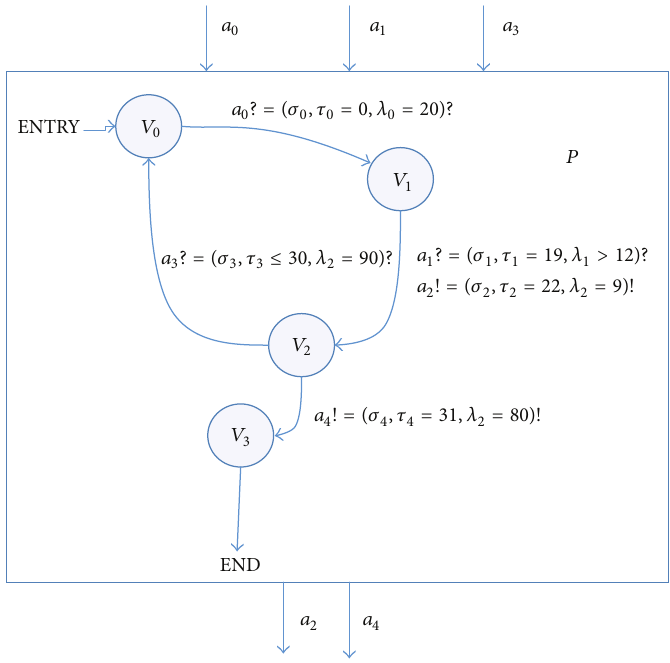
Figure 2: A simple example of the RTEIA 𝑃 .